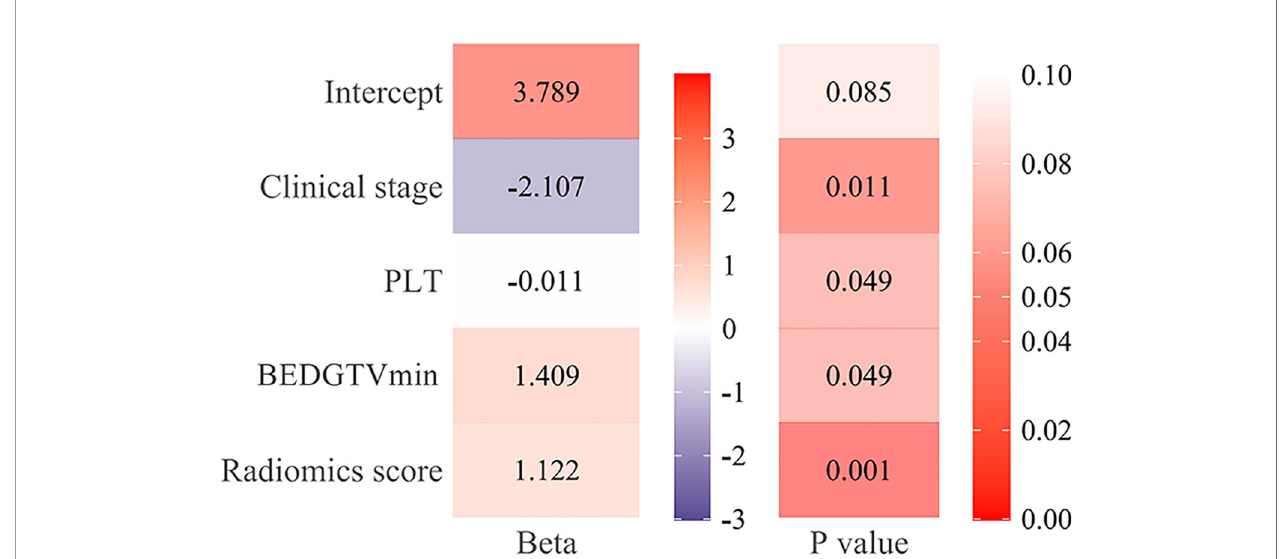
FIGURE 7 | The function of each feature in the combined model. The beta value and the p -value of radiomics score, clinical stage [III~IV], platelet (PLT), and BEDGTV min [ ≥ 98.79] in the combined